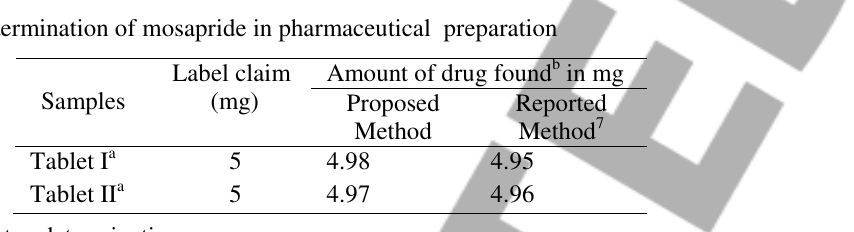
Table 2. Determination of mosapride in pharmaceutical preparation